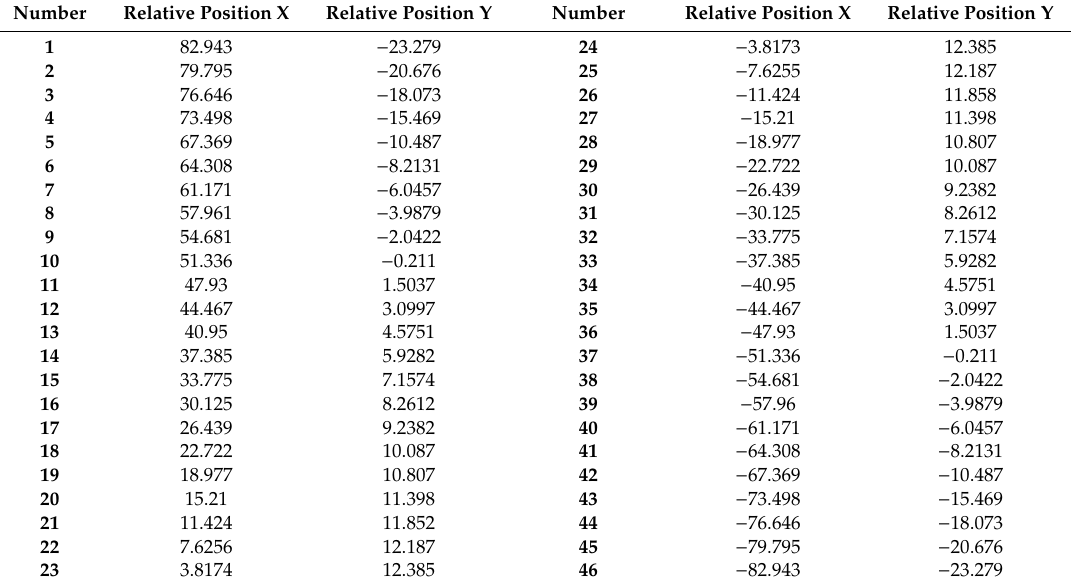
Table 1. Relative coordinates of sample points under digital-to-analog